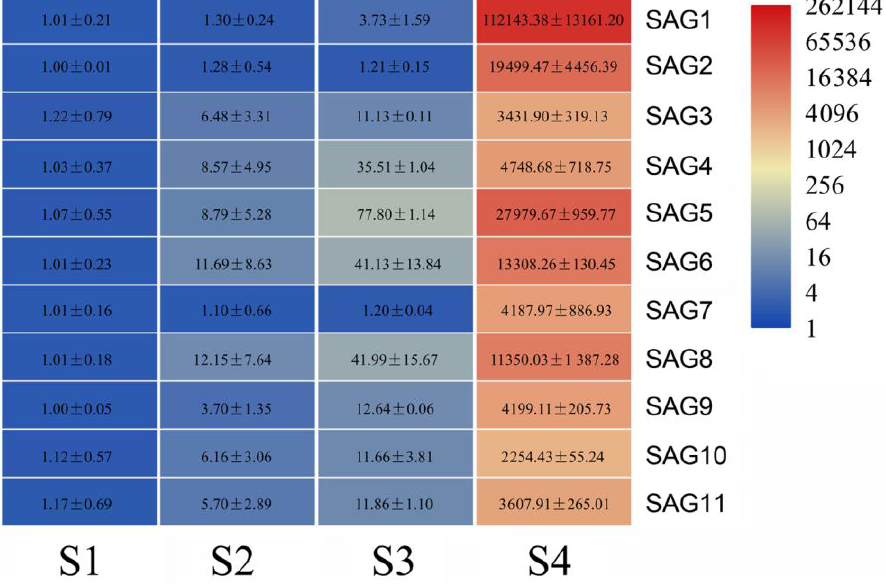
Figure 4. Expression of eleven senescence-associated genes during flower opening by qRT-PCR analysis. Different colors indicate the expression level of genes. The data represent the mean ± SE of three biological replicates. ACTIN from lily ( Lilium oriental ‘Siberia’) ( LoACTIN ) was used as the internal